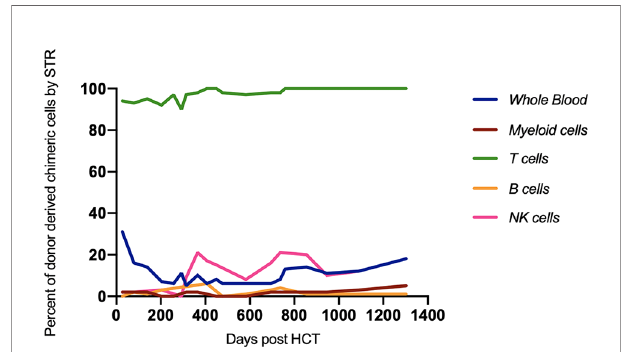
FIGURE 4 | Donor percent chimerism as measured by STR was followed over time. Full donor-derived T cell chimerism was maintained. HCT, hematopoietic cell transplant; STR, single